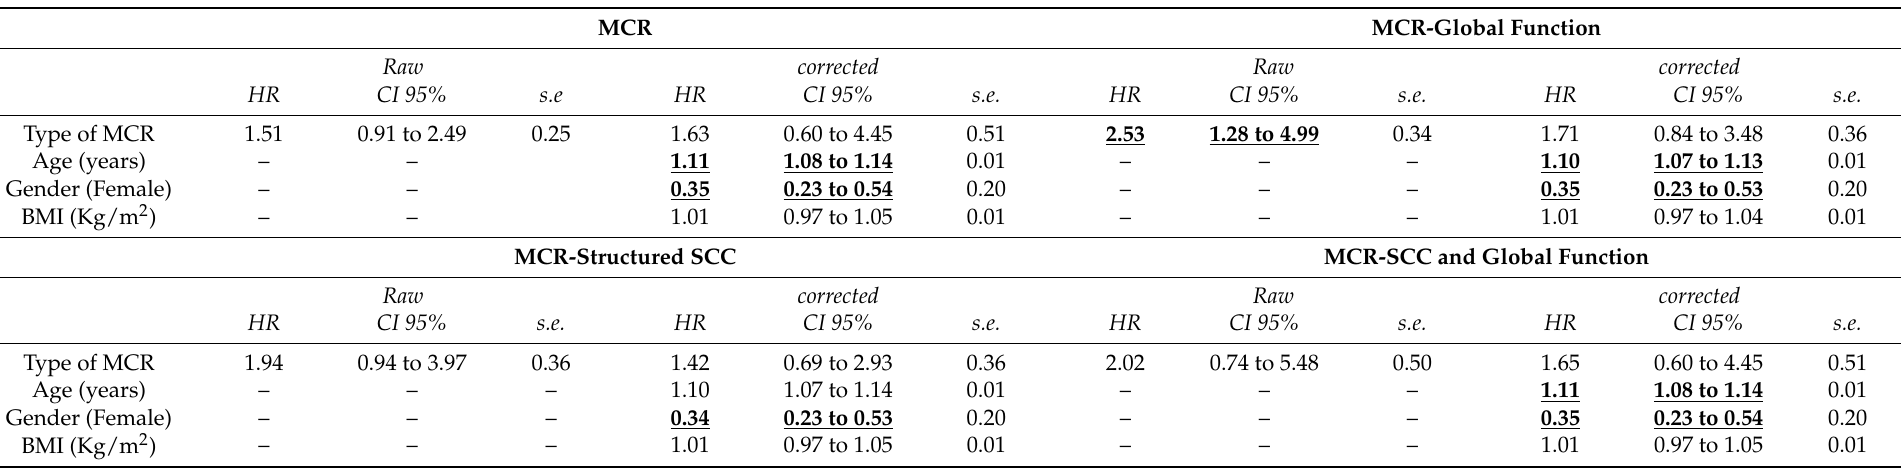
Table 3. Results of Cox regression models for each type of